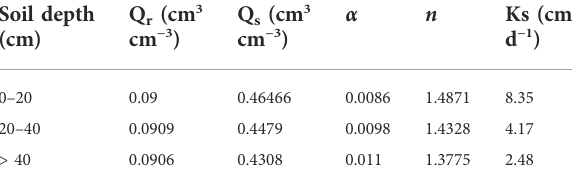
TABLE 3 VG model soil moisture characteristic